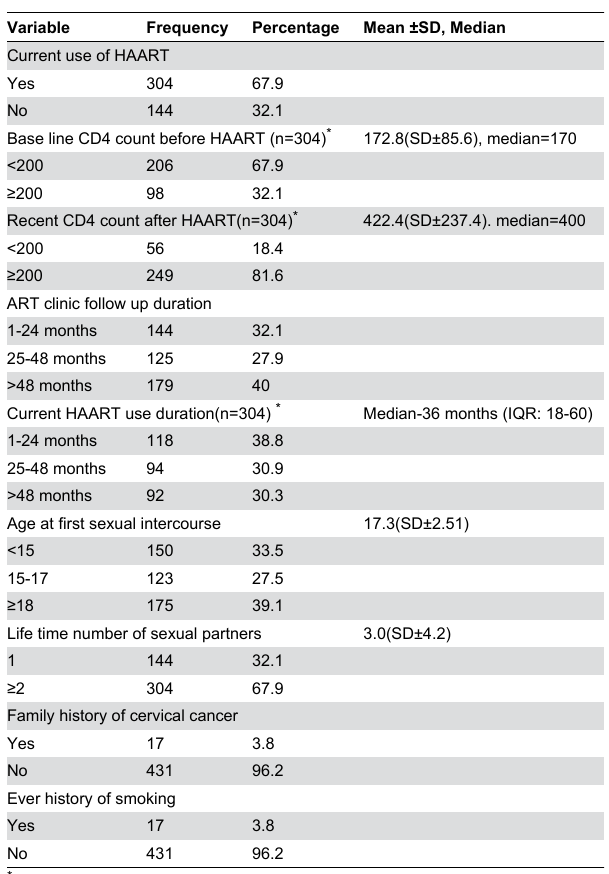
Table 4. Logistic regression analysis of factors associated with precancerous cervical cancer lesion (PCCL) in Southern Ethiopia, 2013.